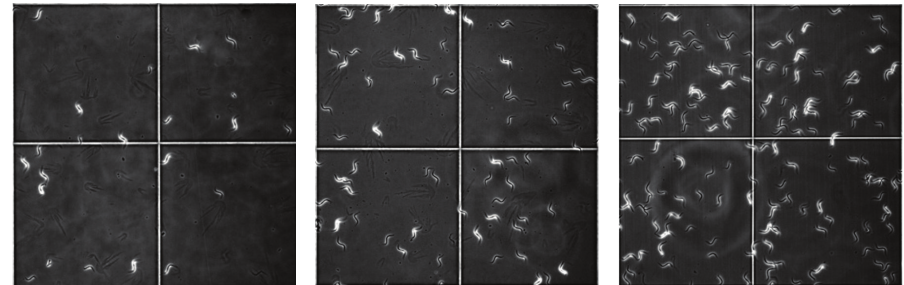
Figure 5: Monoraphidium sp. culture in absence of 232 Th (left); in presence of 0.5mg/L 232 Th (center); in presence of 10.0mg/L 232 Th (right) (20-fold increase).